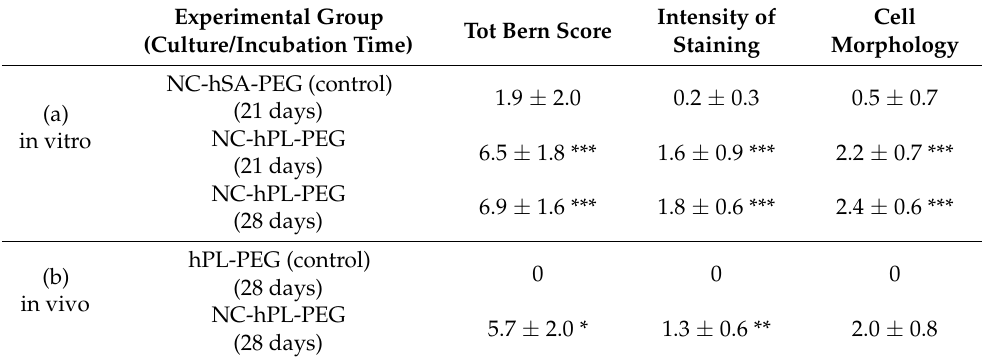
Table 1. Total Bern score, Intensity of staining and Cell morphology of in vitro and in vivo NC-hPL- PEG